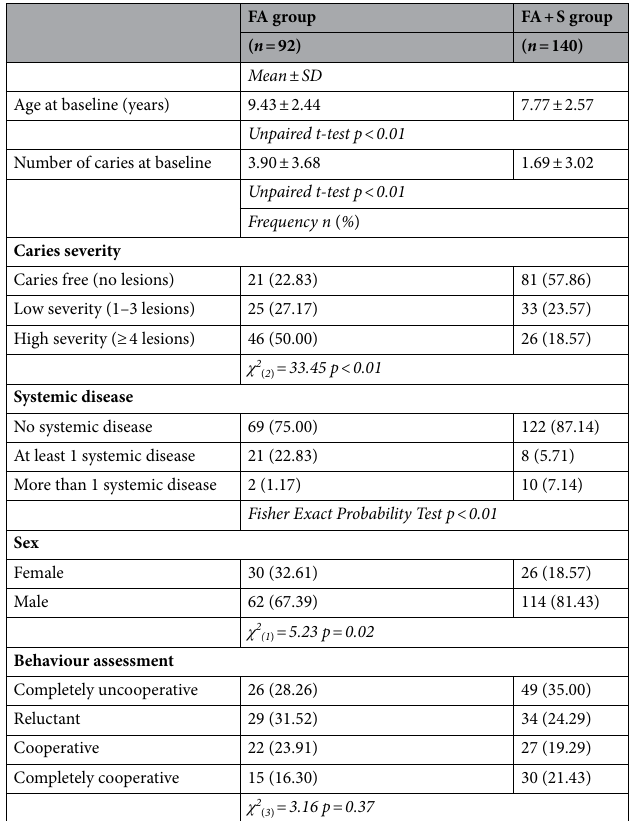
Table 1. Description of the sample enrolled at the first dental